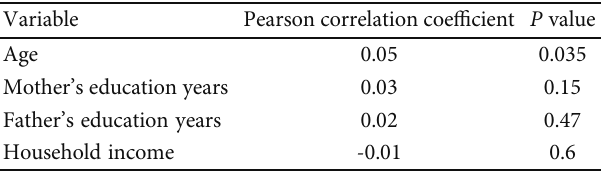
Table 5: Correlation between high school students ’ age, their parent ’ s education level, and household income with mental health